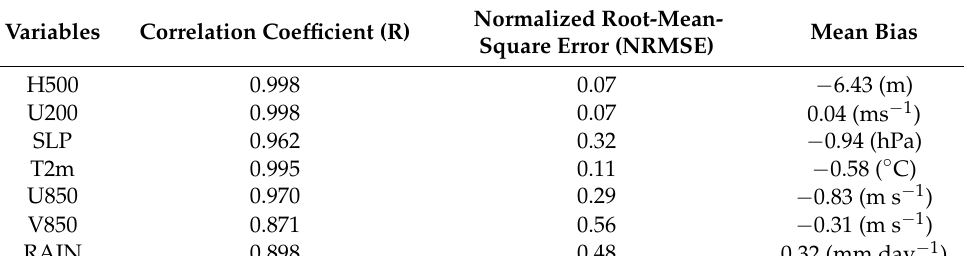
Table 2. List of verification results for climatology. H500, U200, SLP, T2m, U850, V850, and RAIN are